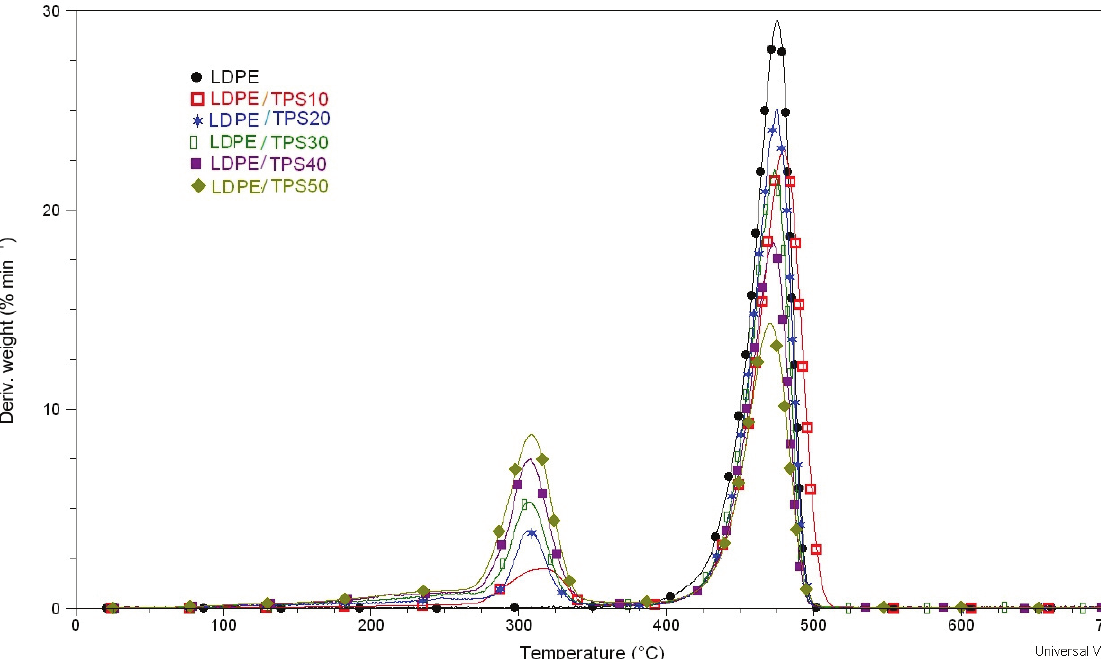
Fig. 7 – DTG curves of LDPE / TPS